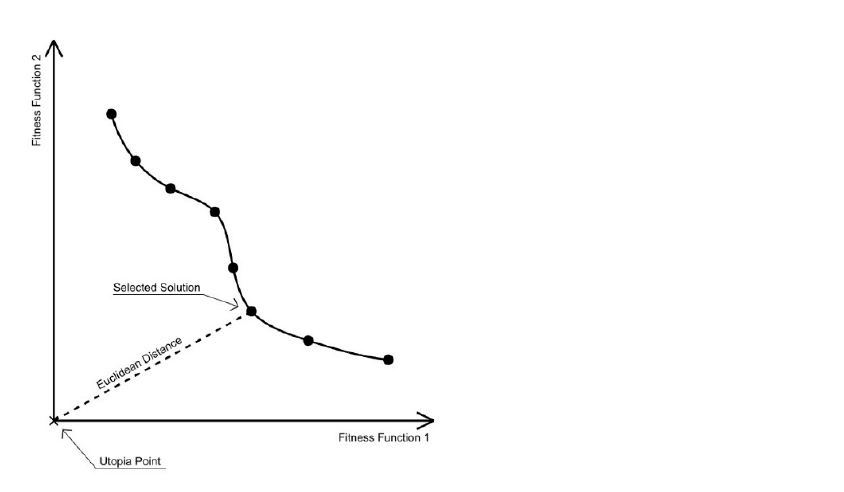
Figure 4. Example of the ‘global compromise’ solution. This solution is the closest (Euclidean) solution to the ‘Utopia’ solution.